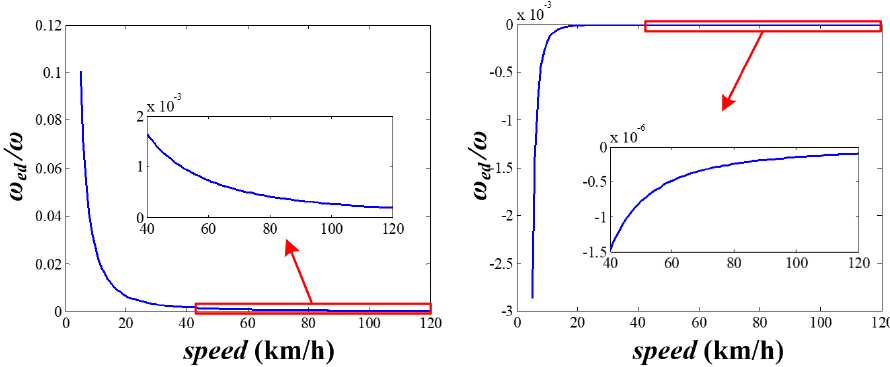
Figure 7. The evaluation error of the rotational speed with changing vehicle speed.